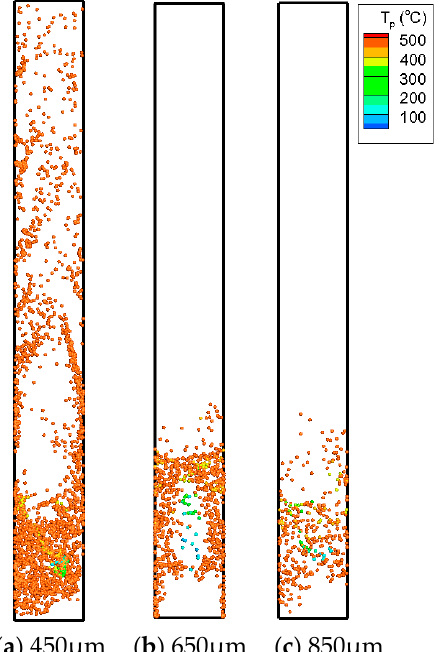
Figure 14. Biomass particle distribution at t = 10 s for different particle sizes.